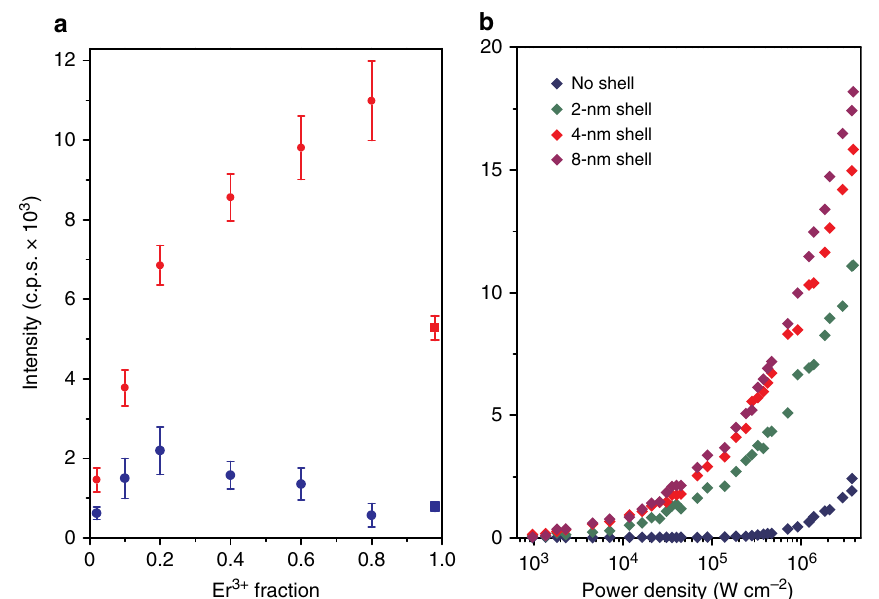
Fig. 2 Enhancement of single UCNP emission. a Single-particle emission (496 – 745 nm) as a function of Er 3 + content. Blue and red circles are 8 nm NaY (0.8 − x ) Er x Yb 0.2 F 4 cores and with 4 nm shells, respectively. Blue and red squares are NaErF 4 and NaErF 4 core/shells, respectively. Excitation density is 2 × 10 6 W cm − 2 . Error bars are one standard deviation from the mean ( n ≥ 50). b Laser intensity-dependent effects of inert shell thickness on